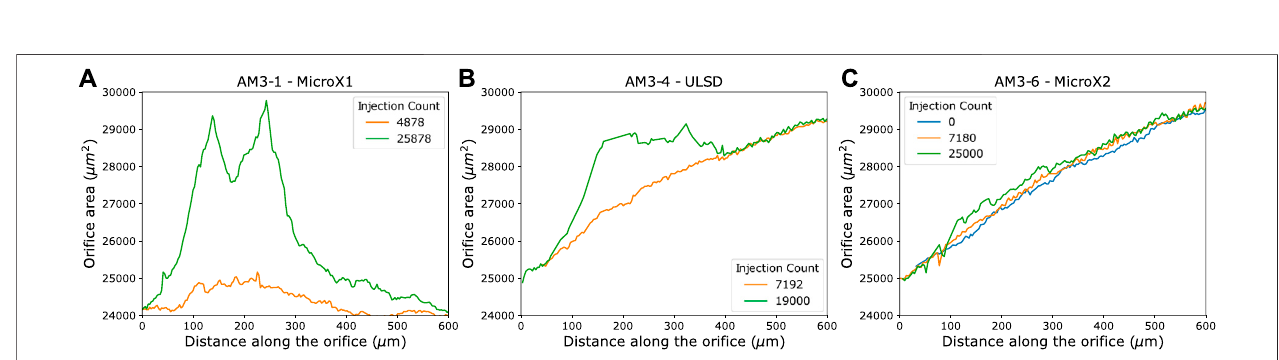
FIGURE 5 | Ori fi ce area quanti fi ed using the single ori fi ce tomographyc reconstruction. (A) AM3-1 with ULSD-MicroX1. (B) AM3-4 with ULSD. (C) AM3-6 with ULSD-MicroX2.